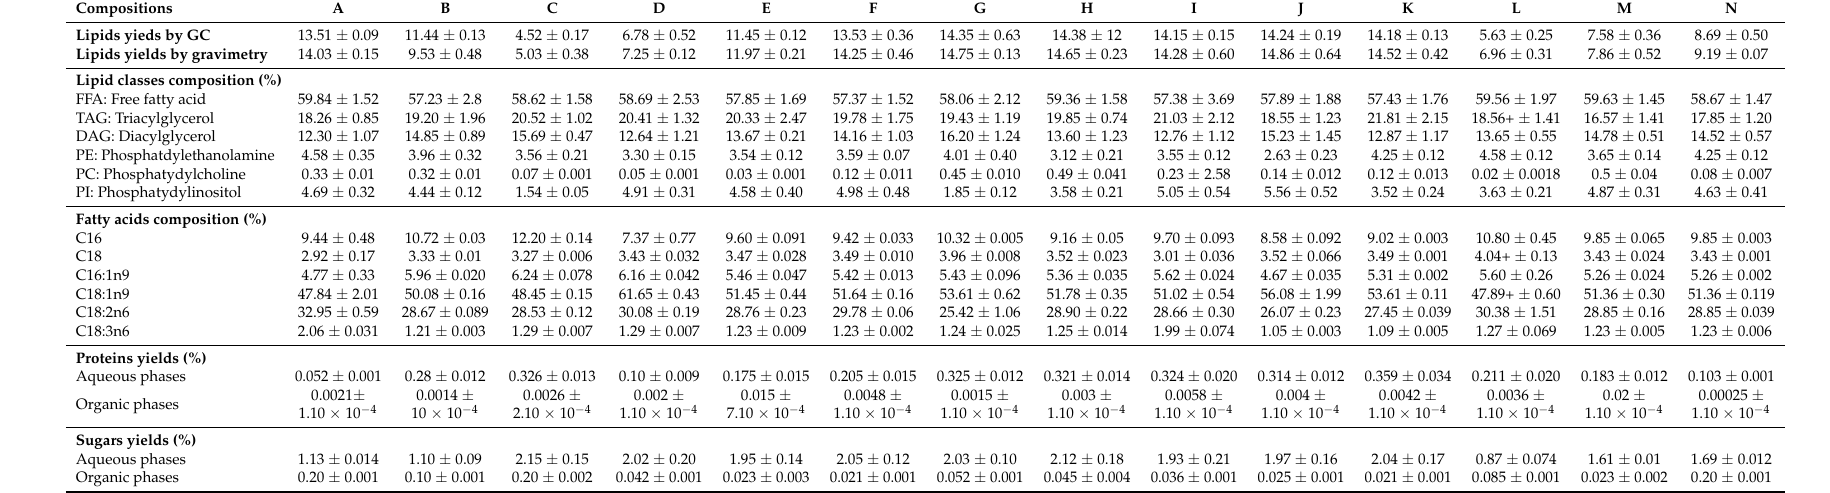
Table 3. Crude lipids, distribution of lipid classes, fatty acids, proteins and glucose compositions of extracts (organic and aqueous phases) obtained by extractions with different ratios of alternative solvents. Lipid yields and gravimetric yields (g per 100 g of dry matter), lipid classes and fatty acids compositions (relative percentages). Proteins and sugars yields in g per 100 g of dry